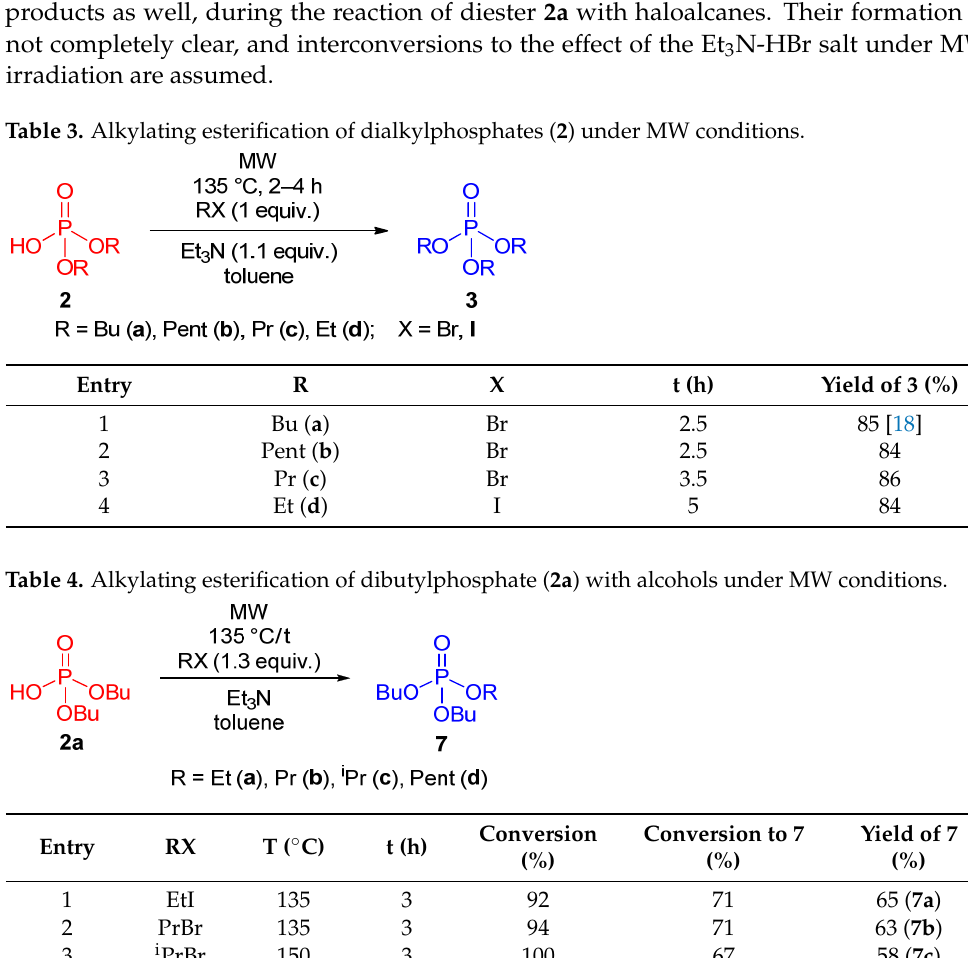
Table 3. Alkylating esterification of dialkylphosphates ( 2 ) under MW conditions.